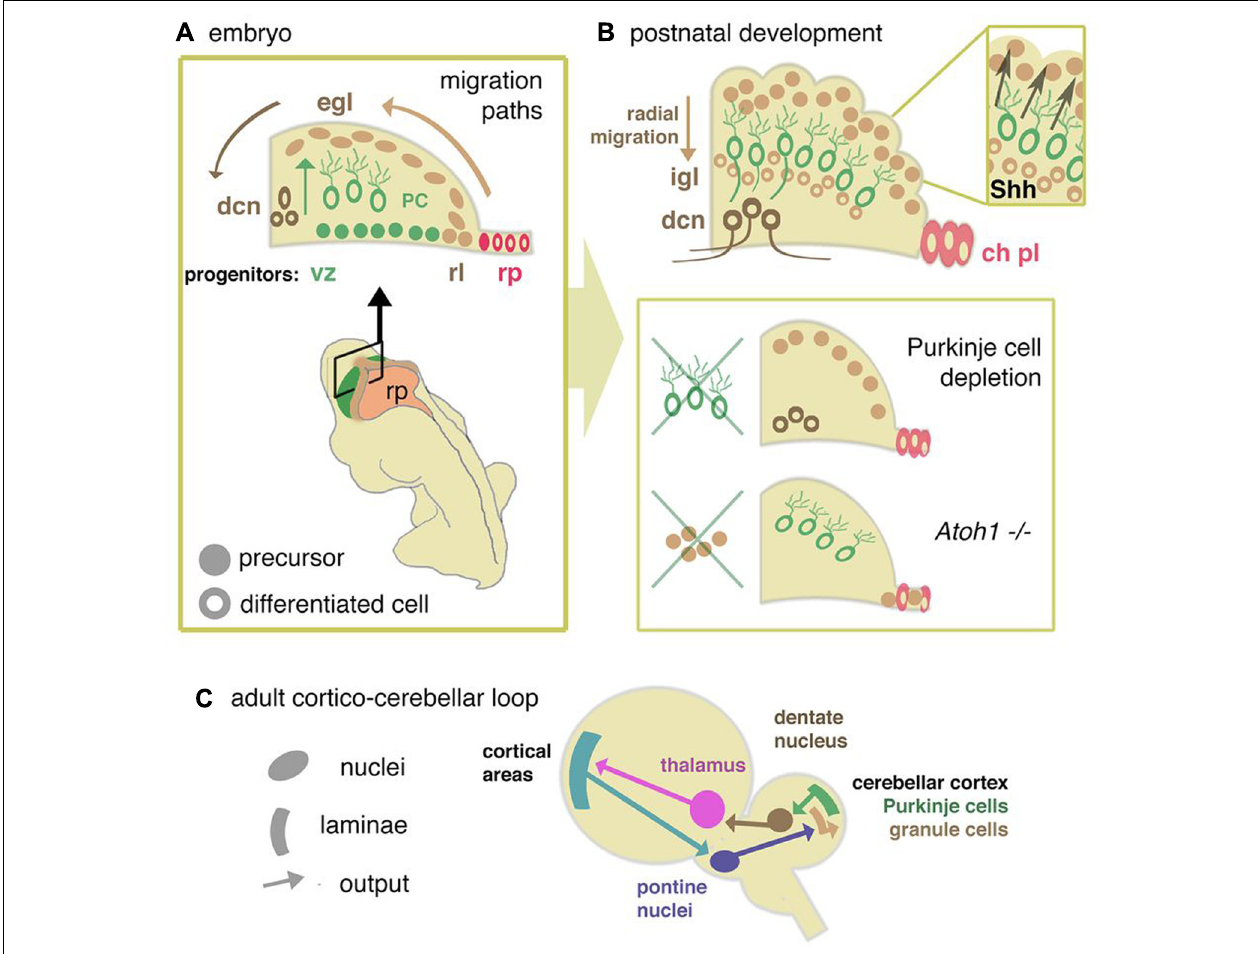
where egl formation is suppressed (as in the Atoh1 knockout mouse), cerebellum growth is reduced. Disruptions in signals from the overlying mesenchyme, directly or through affecting signaling from the roof plate, may modulate the responsiveness of the egl to mitogens, thus abrogating its expansion. (C) From data derived in the primate (Strick etal., 2009) a general model for a mammalian circuit would propose that cortico-cerebellar closed loops modulate cortical activity for a number of different motor and non-motor cortical areas.Without presupposing details of cortical areas in the mouse, cortical activity would be anticipated to feed into the cerebellar circuit via the pontine nucleus, a derivative of the rhombic lip of the hindbrain. Cerebellar output via dentate nucleus neurons would then feed back to the cortical areas via the